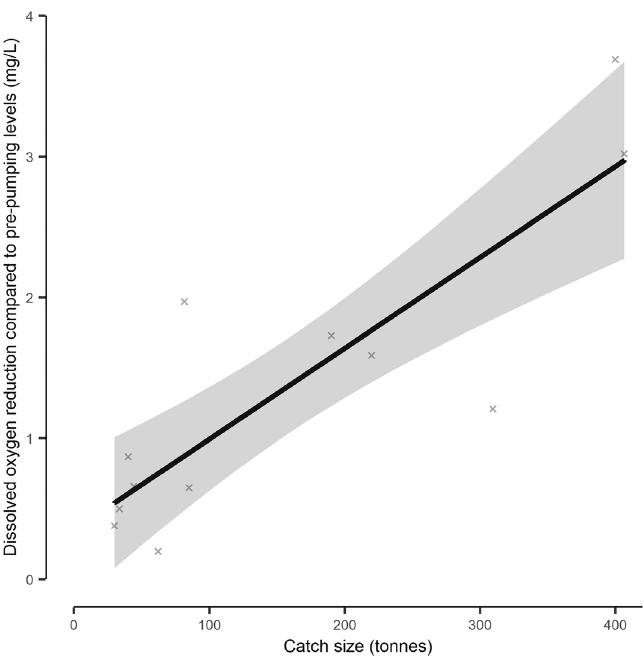
Figure 5. The model derived relationship between catch size and dissolved oxygen concentration reduction during pumping of Atlantic mackerel ( Scomber scrombrus ) purse seine catches. The reduction in oxygen is in comparison to pre-pumping levels. The shaded area indicates the model derived 95% confidence interval, with the underlying data indicated as